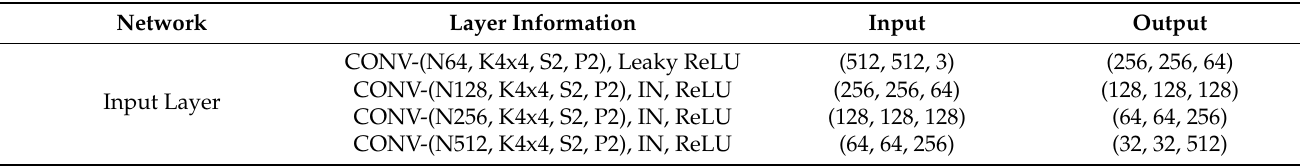
Table 3. The system architecture of the